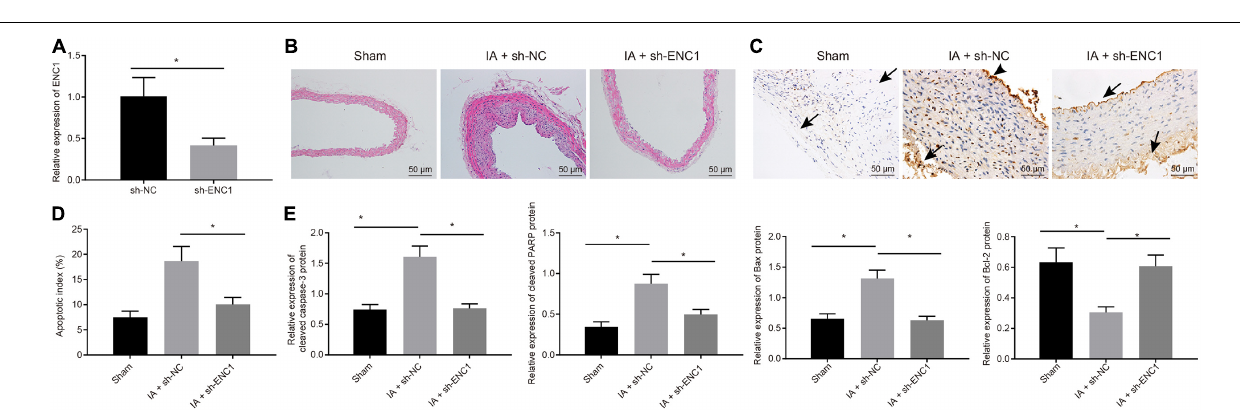
FIGURE 6 | Silencing ENC1 reduces endothelial cell apoptosis in vivo to protect rats from IA. Rats were induced with IA model and treated with sh-ENC1 or sh-NC, with the sham-operated rats as control. (A) The expression of ENC1 in rats determined by RT-qPCR. (B) HE staining ( × 200) for the ACA/OA branch sections of rats. (C) The representative images of TUNEL staining ( × 200) for apoptosis of rats (arrows indicate the arterial wall). (D) Quantitative analysis of cell apoptosis in rats evaluated by TUNEL staining. (E) The expression of apoptosis-related factors (cleaved Caspase-3, cleaved PARP1, Bax, and Bcl-2) as determined by Western blot analysis and quantified by Image J software. * p < 0.05. The measurement data were expressed as mean ± standard derivation. Comparisons between two groups were analyzed by unpaired t test, and comparisons among multiple groups were analyzed by one-way ANOVA and followed by Tukey’s post hoc test. The cell experiment was conducted three times independently. The sham group: n = 12, the IA + sh-NC group: n = 12, and the IA + sh-ENC1 group: n =